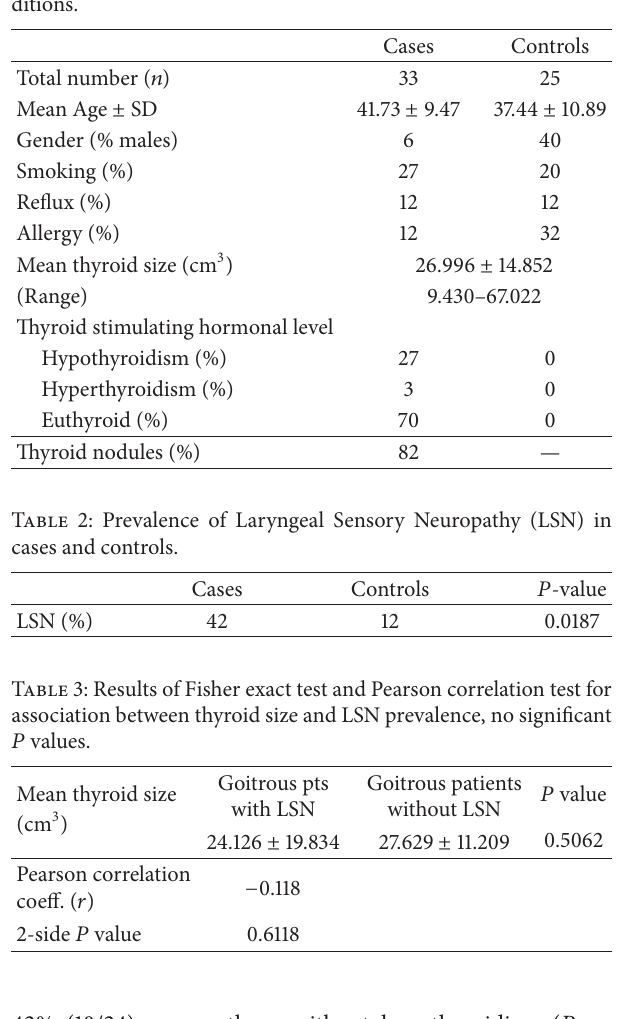
Table 1: Demographic data for cases and controls, including pre- valence of smoking, reflux, allergies, and concurrent endocrine con- ditions.